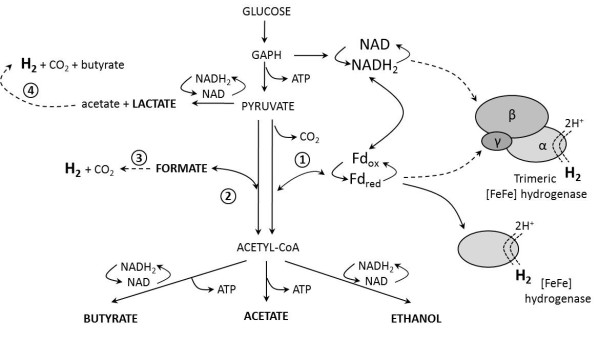
A simplified overview of the main metabolic pathways involved in H2production byClostridium spp. Dashed lines indicate hypothetical pathways. 1-PFOR, 2-PFL, 3-[FeFe] TR(M2) hydrogenase [32], 4-pathway proposed by Matsumoto et al., [33], Fdox/red-ferredoxin oxidized/reduced.